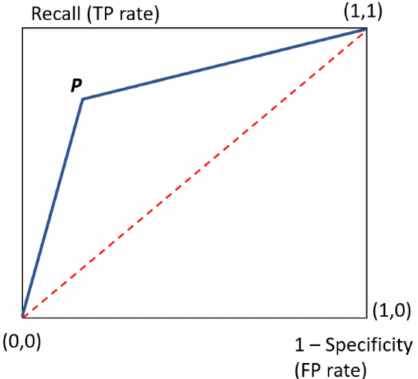
Figure A1. Example of Receiver Operator Characteristic (ROC)